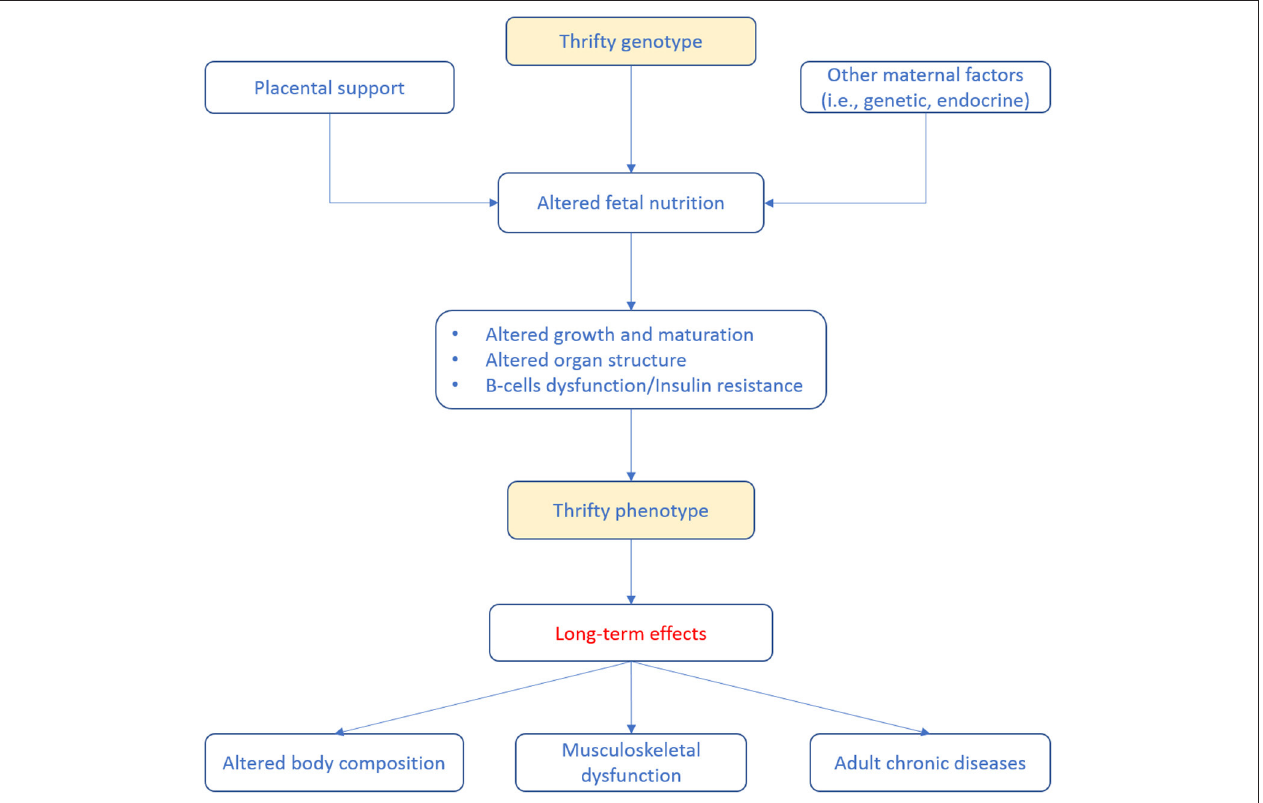
FIGURE 1 | Life-course events predisposing to adult diseases according to the so-called thrifty phenotype hypothesis (53). Poor infant growth, as a consequence of in utero undernutrition, may lead to alterations in glucose-insulin metabolism that, coupled to the effects of obesity, aging and physical inactivity, promotes the development of adult